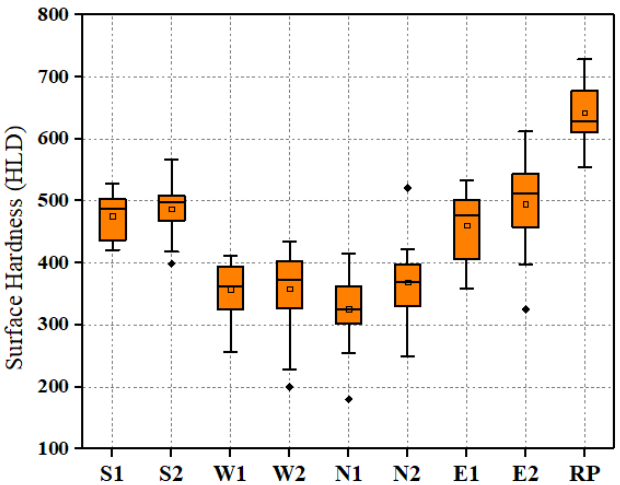
Figure 6. Boxplot of surface hardness value of the stone house.